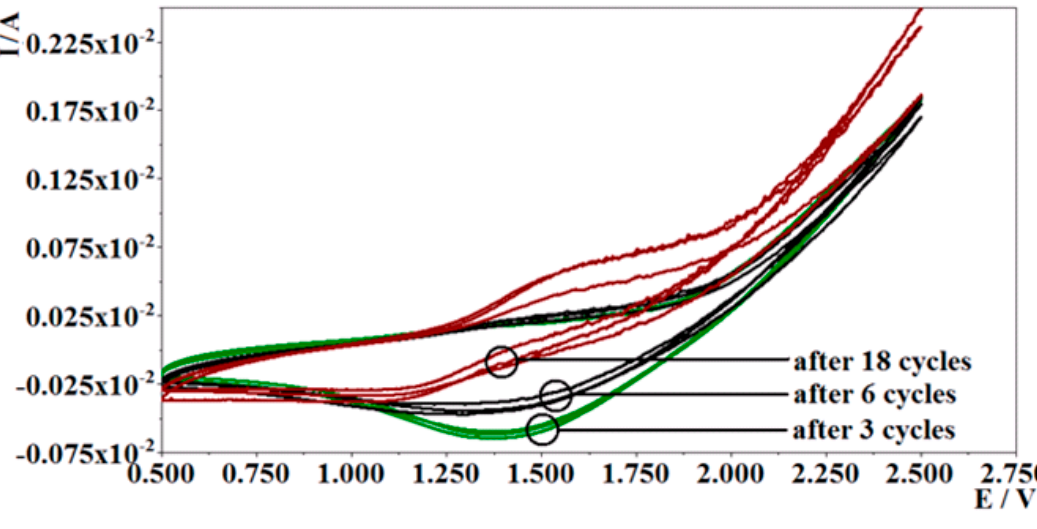
Figure 1. Cyclic voltammograms obtained during potential cycling-based polymerization of 0.001 M PQ in 0.1 M of tetra- n -butylammonium perchlorate in acetonitrile, under a scan rate of 100 mV / s vs. Ag / AgCl / KCl (3M KCl) .